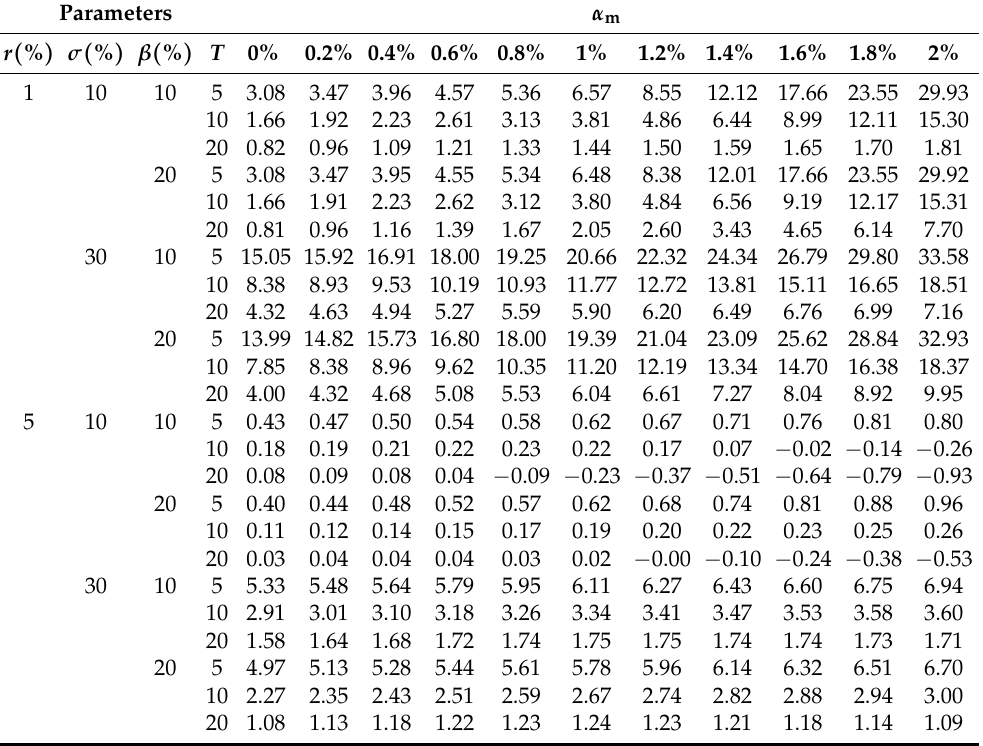
Table 2. Fair fee rate α ins (%) based on the total value maximization strategy Γ V . Parameters α m